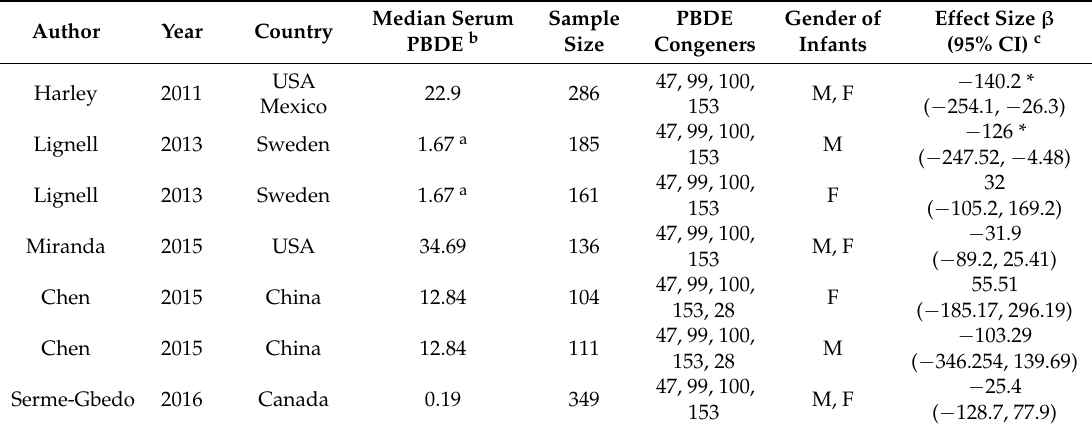
Table 1. Abstracted major information from the included epidemiological studies on the relationship between polybrominated diphenyl ether (PBDE) levels and birth